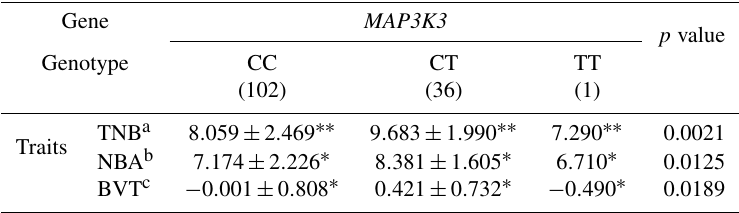
Table 7. Association of litter size traits with genotypes of MAP3K3 in the primary experiment.